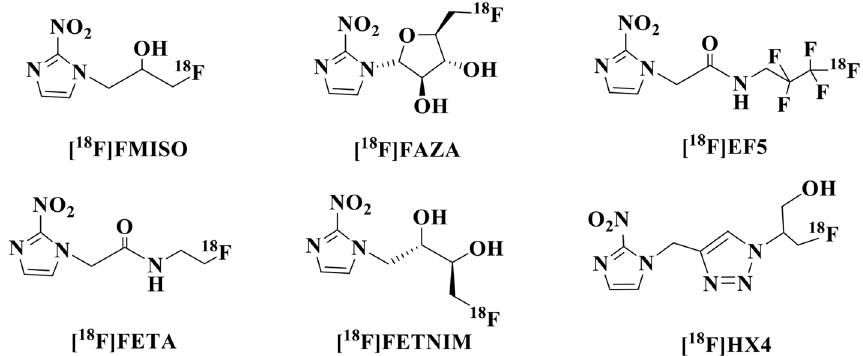
Fig. 1 Chemical structures of selected 18 F-labeled 2-nitroimidazoles used for PET imaging of tissue hypoxia